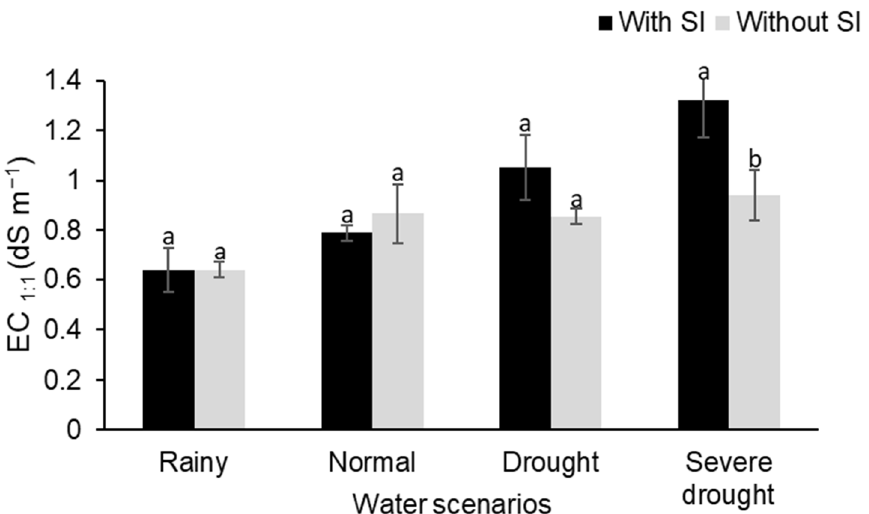
Figure 3. Soil electrical conductivity (soil:water extract 1:1) cultivated with maize under different water scenarios, with or without supplemental irrigation (SI) with brackish water (ECw = 4.5 dS m − 1 ). For each water scenario, means followed by the same letters do not differ ( p ≥ 0.05) from each other according to the Tukey test. Error bars represent the standard error of the mean ( n = 4).